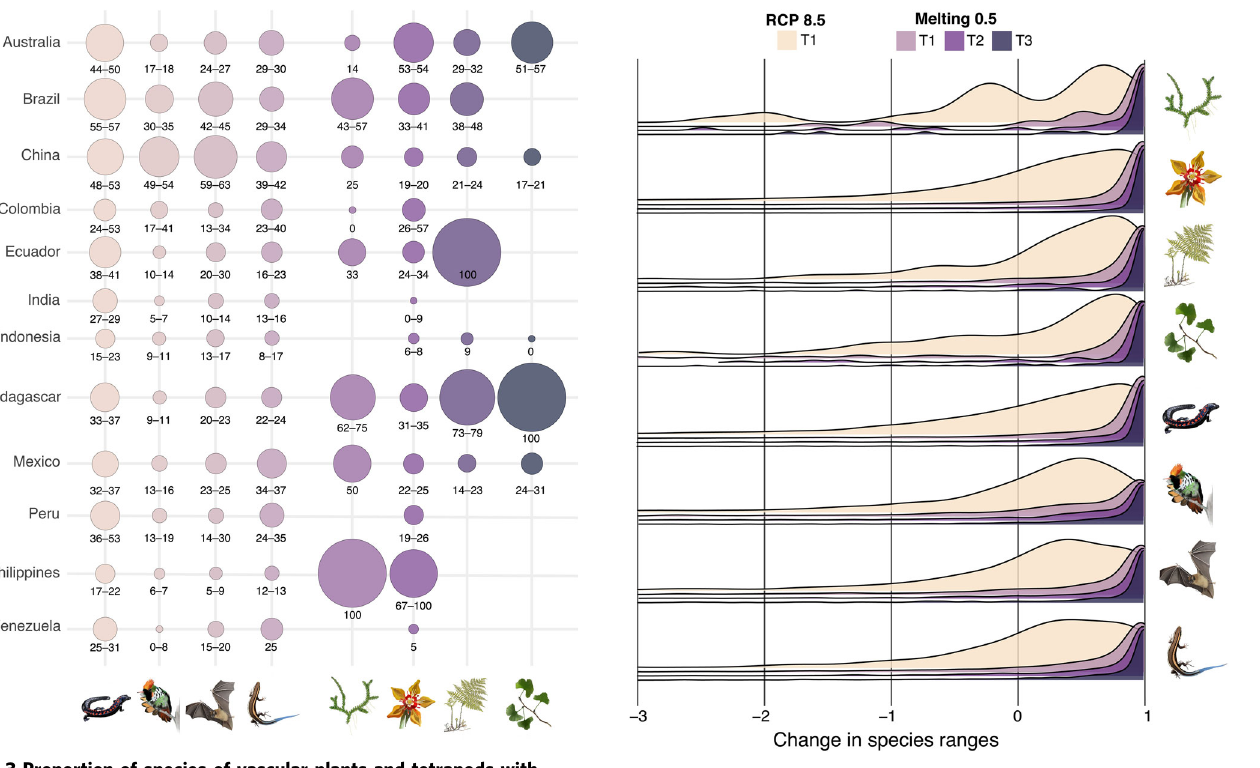
Fig. 4 Changes in the size of the distribution range of species of vascular plants and tetrapods. Estimates of range size were based on species distribution models (SDMs). Range sizes were standardized relative to the present-day species range size: positive values indicate range reductions (1 means complete loss), and negative values indicate range expansions. Estimates of range size were aggregated by taxonomic group and visualized using density plots for T1: 2030 under the RCP 8.5 scenario and for T1: 2030, T2: 2050, and T3: 2070 under the Melting 0.5 scenario. Groups of species are indicated by the inset illustration (from top to bottom): lycophytes, fl owering plants, ferns, gymnosperms, amphibians, birds, mammals, and